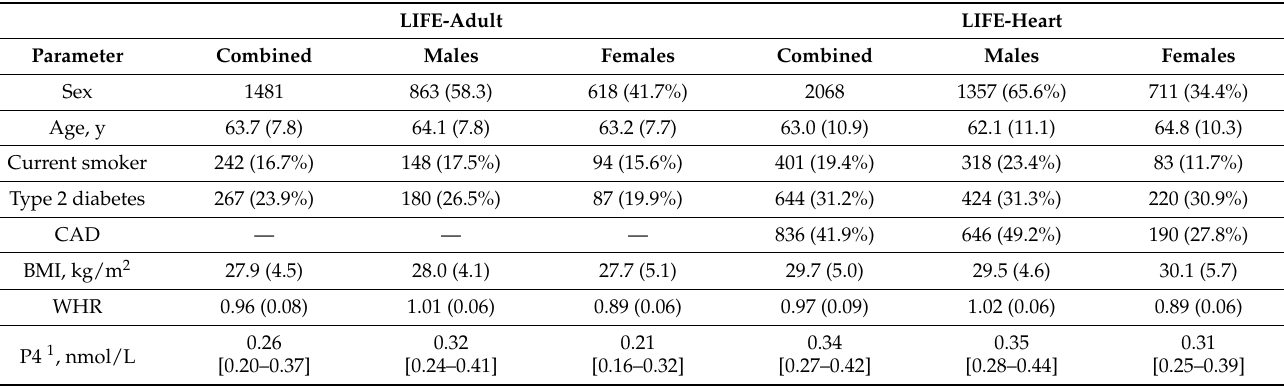
genes is provided in the supplemental materials.